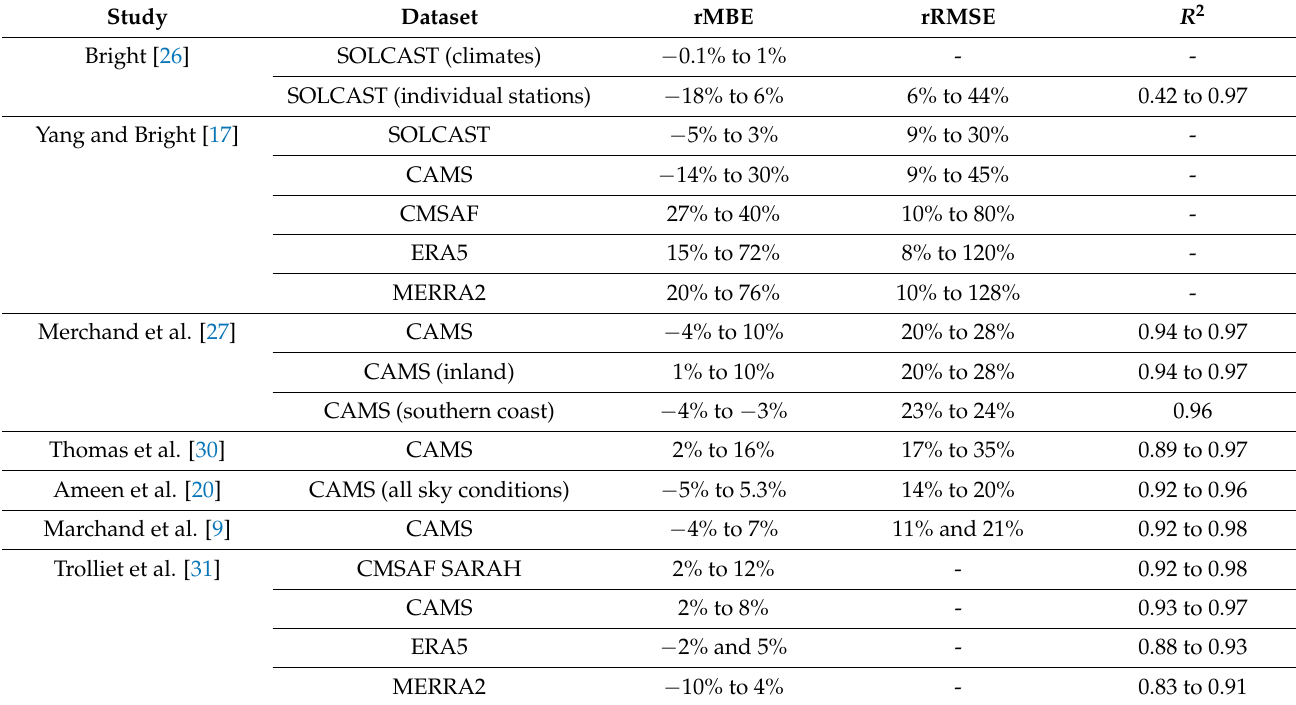
Table 1. Summary of the validation results from the literature review (the rMBE and rRMSE results were rounded off to the nearest whole